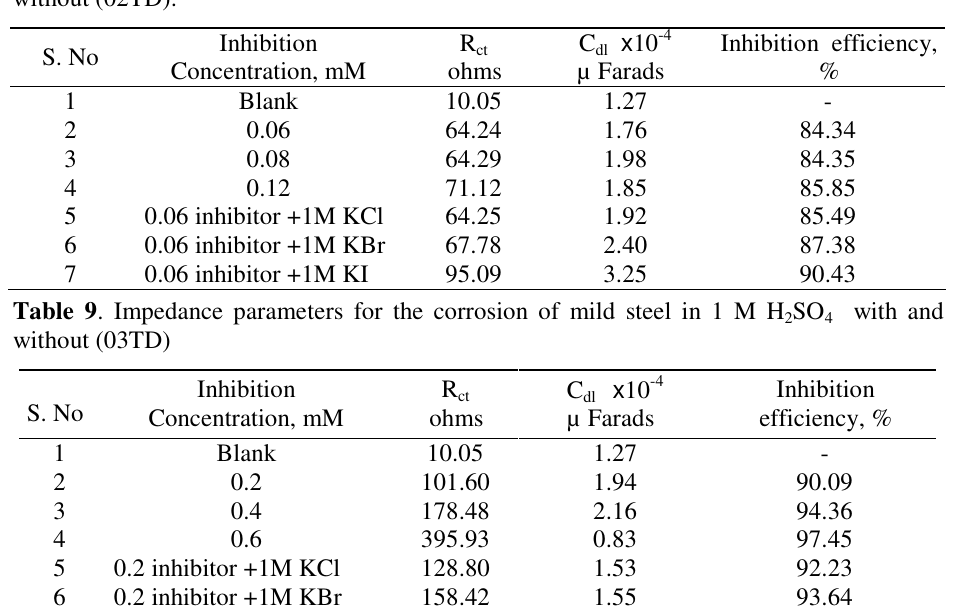
SO with and 2 4